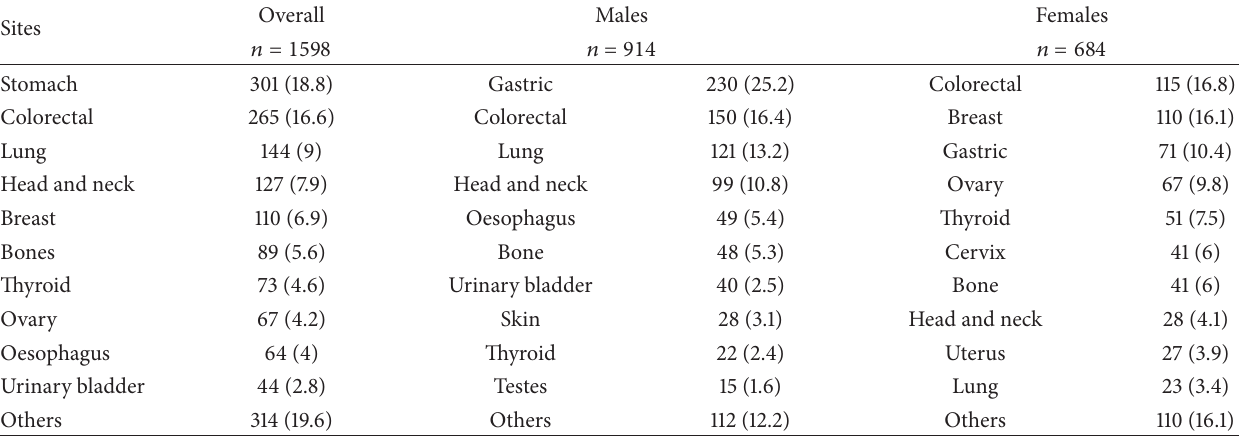
Table 2: Ten most common cancers (overall and across sex).